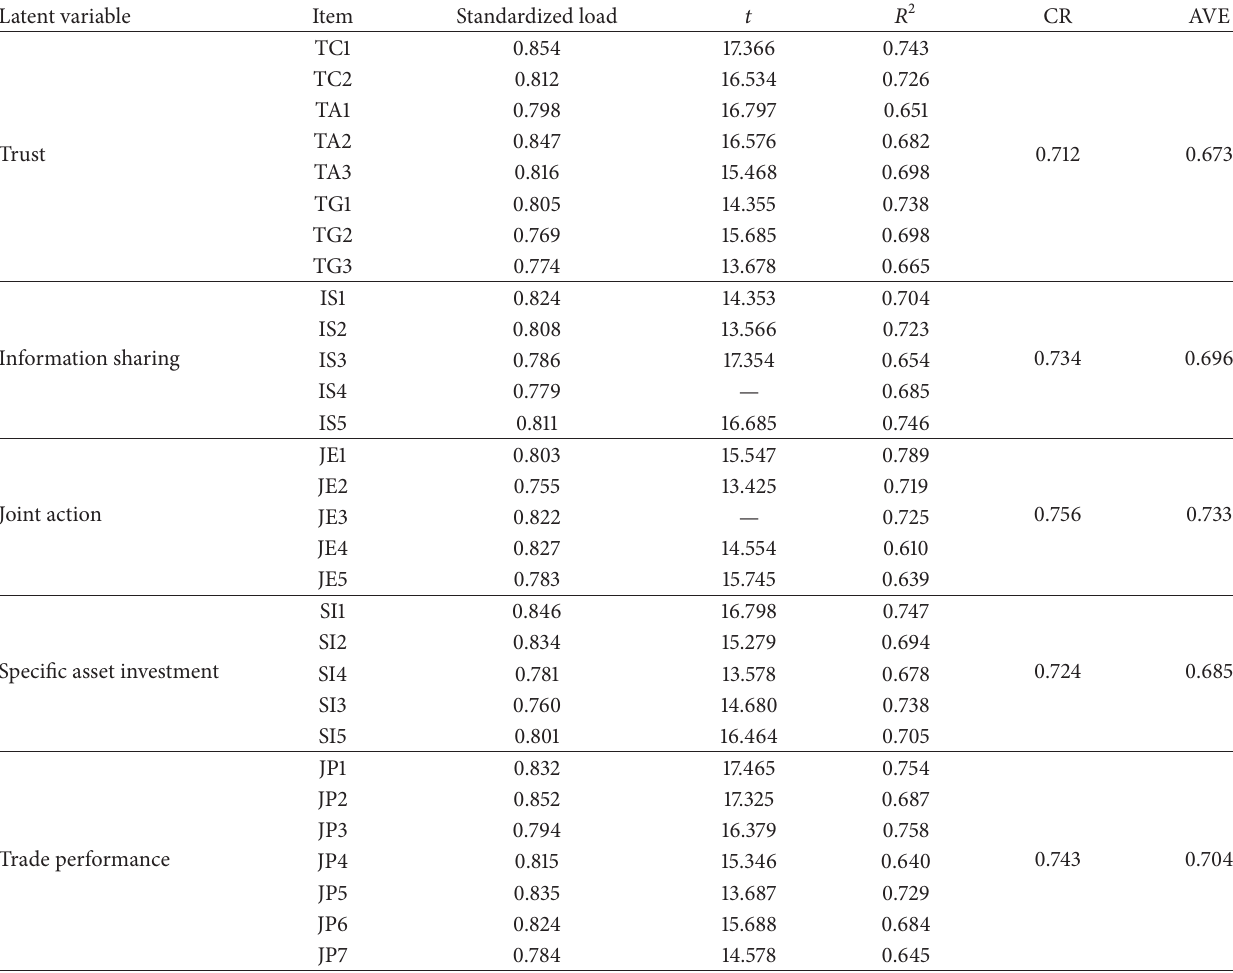
Table 14: The basic situation of model fitting.